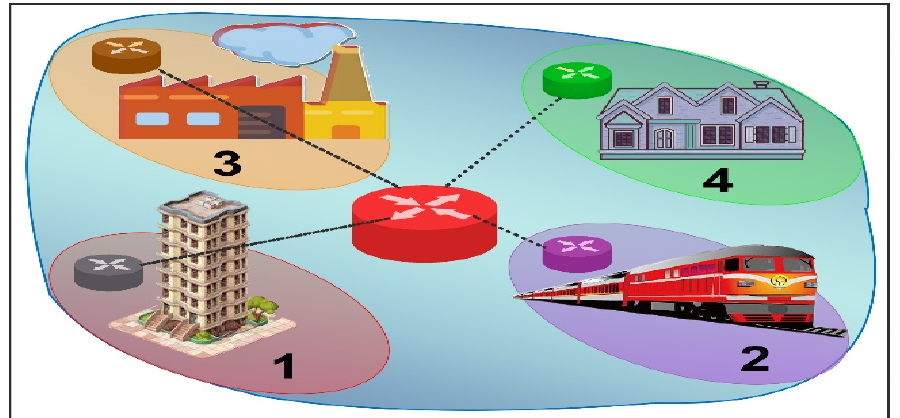
Figure 1. SDS heterogeneous network with router configuration.